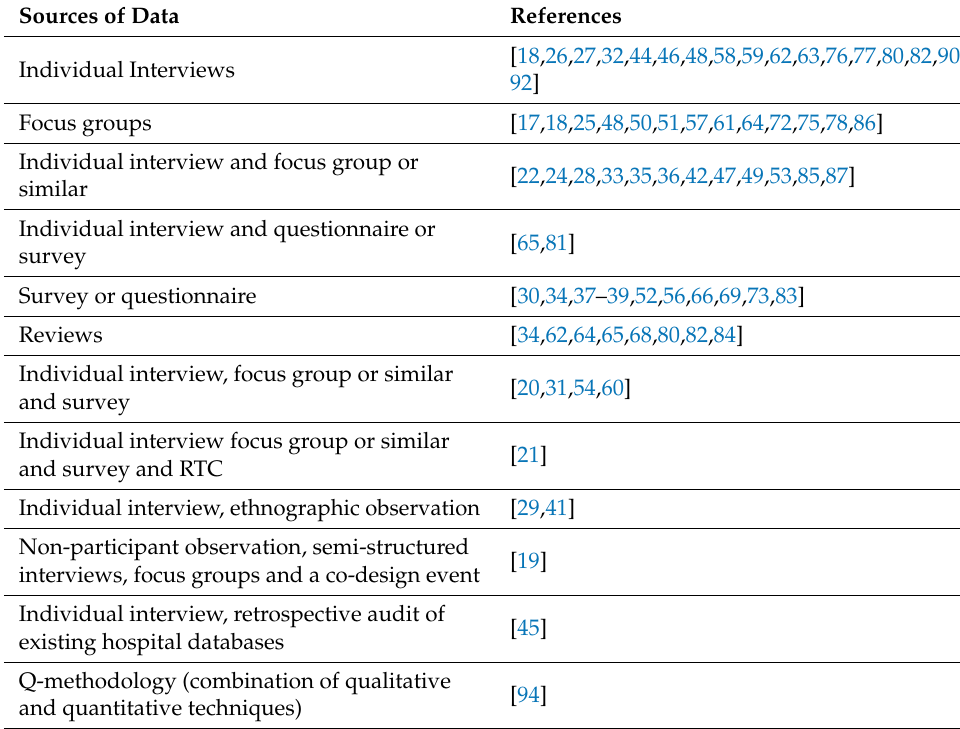
Table 3. Sources of data